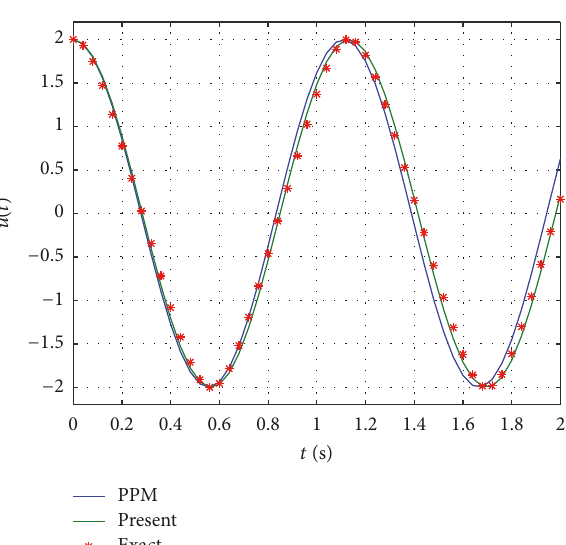
Figure 1: Comparison of time history diagram of displacement between the present, PPM, and exact solutions at 𝛼 = 2, 𝛽 = 10, 𝐴 = 2 , Example 1.